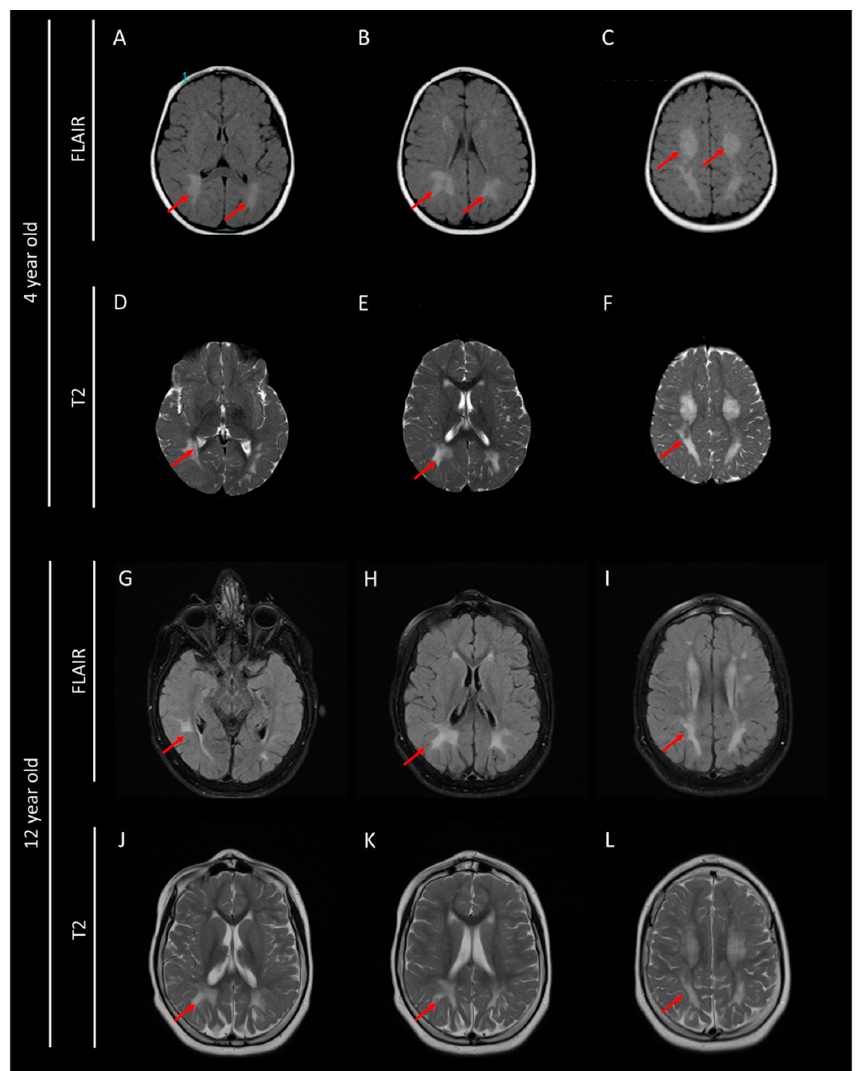
Figure 2. Brain MRI performed at 4 and 12 years old with FLAIR ( A – C , G – I ) and T2 ( D – F , J – L ) sequences. Red arrows show diffuse white matter abnormalities linked to an hypomyelination.